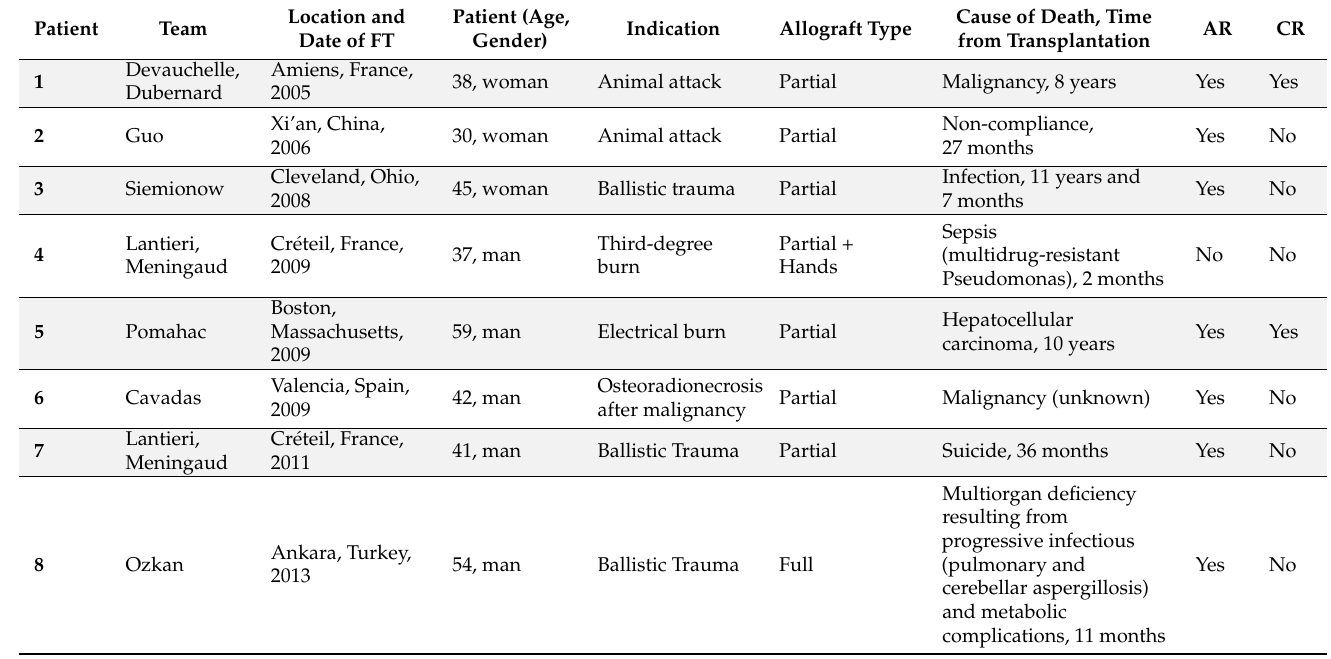
Table 2. Deceased